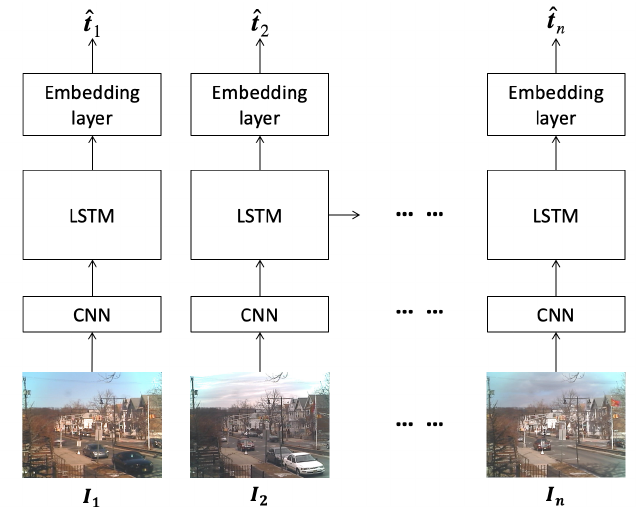
Figure 5. Structure of the proposed LSTM network for temperature prediction